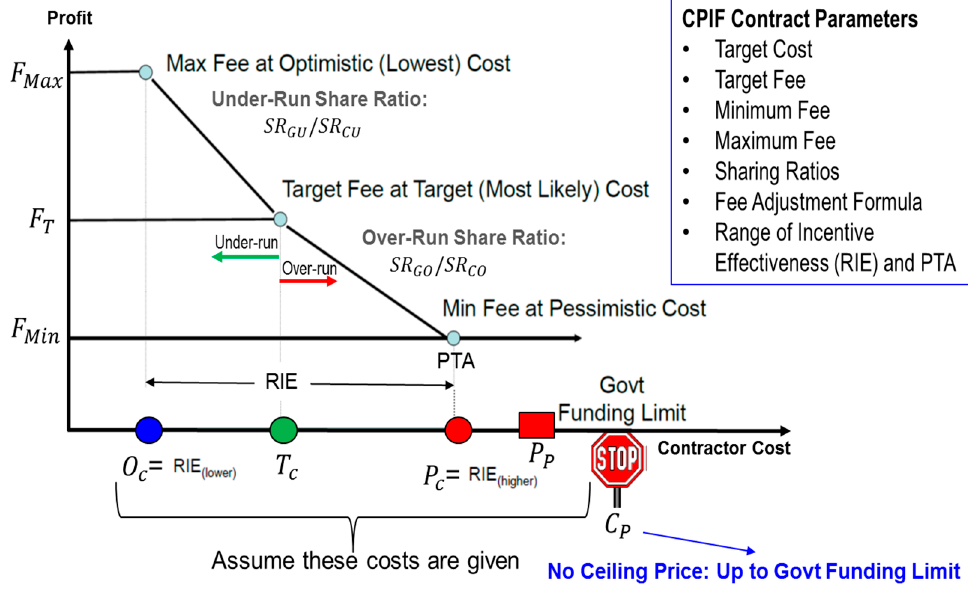
Figure 8. Description of the CPIF Contract’s Parameters Relationship.